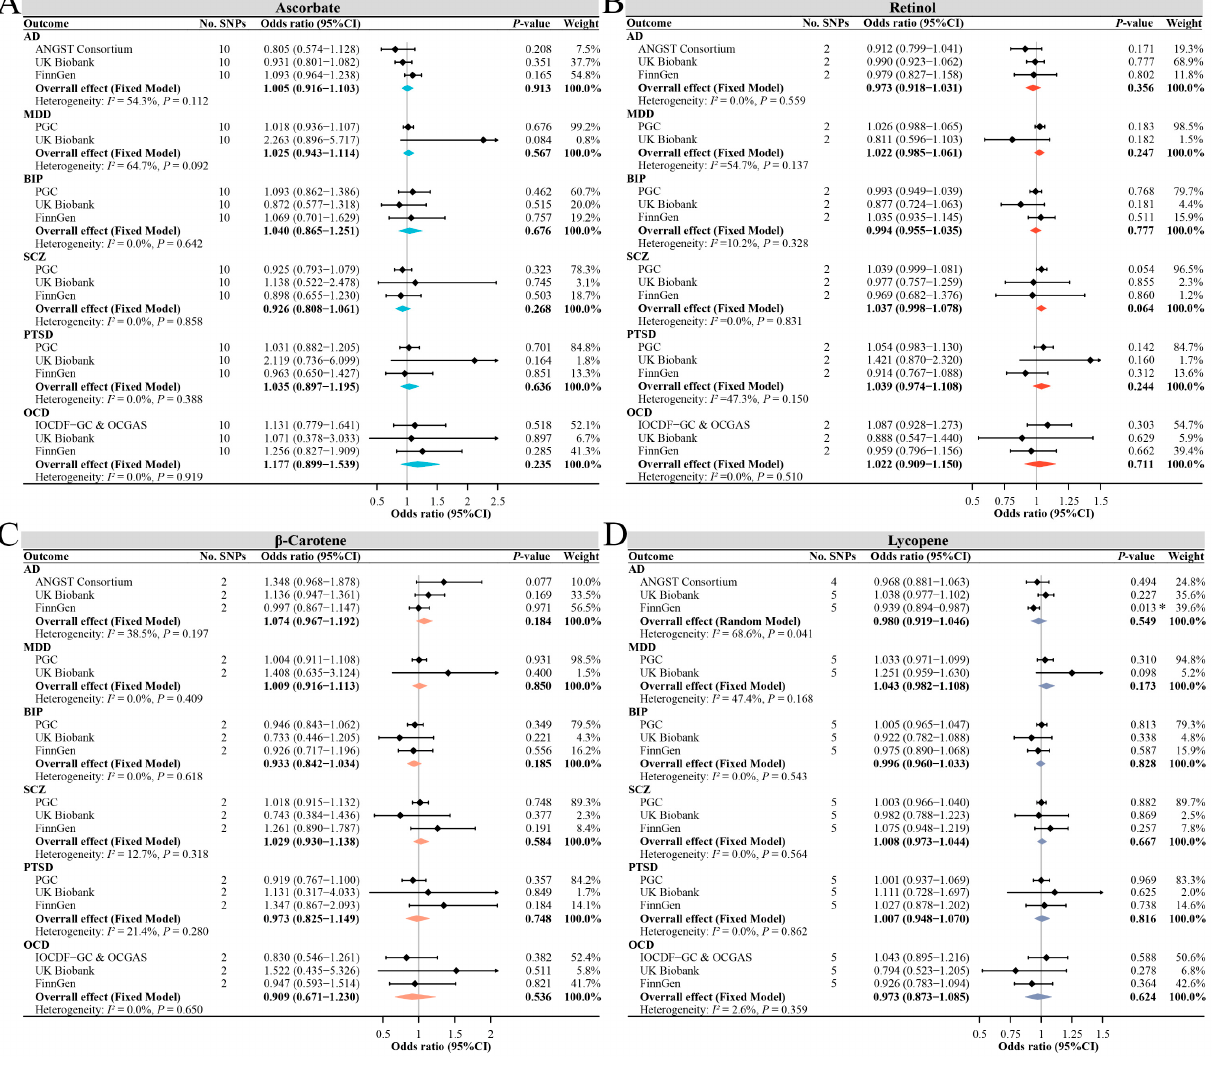
Figure 2. The main MR analysis results of the causal effects of four absolute circulating antioxidant levels on six major mental disorders. The ORs are scaled per µ mol/L increase in ascorbate ( A ), per 0.1 unit increase in ln-transformed retinol ( B ), per unit increase in ln-transformed β -carotene ( C ), and per µ g/dL increase in lycopene ( D ). The asterisk represents a suggestive association (0.001 < p -value < 0.05). Abbreviations: AD, anxiety disorders; MDD, major depressive disorder; BIP, bipolar disorder; SCZ, schizophrenia; PTSD, post-traumatic stress disorder; OCD, obsessive–compulsive